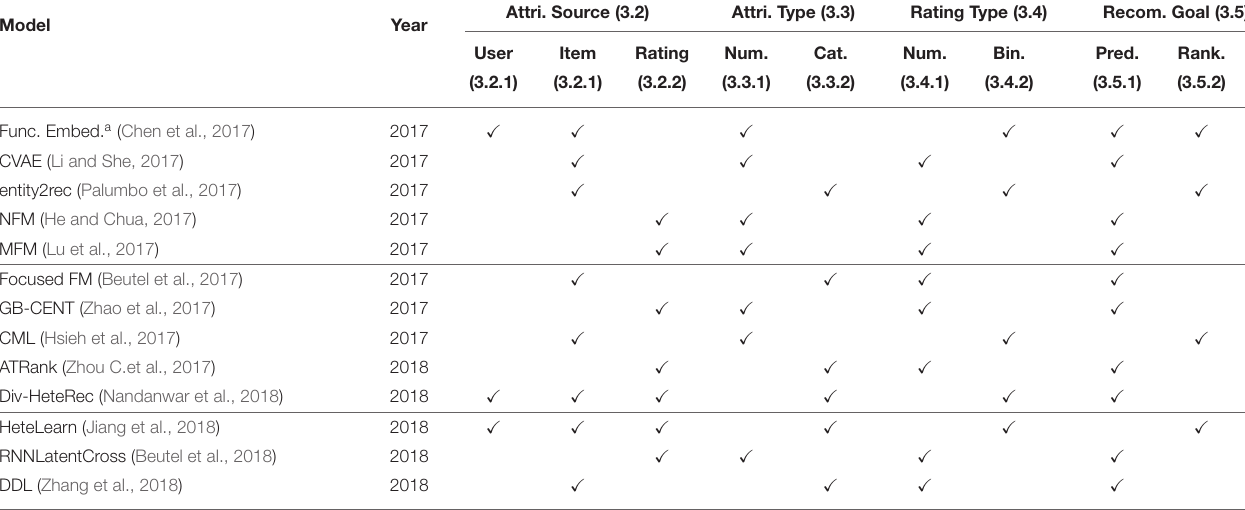
TABLE 4 | List of model categories.